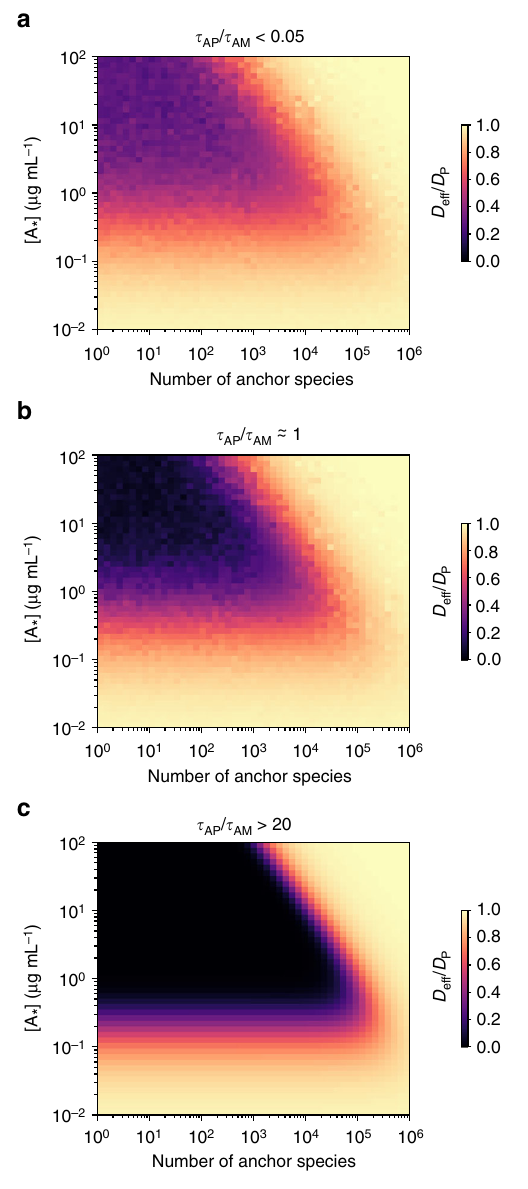
Fig. 5 Potential saturation of trapping potency of molecular anchors. Potential saturation of trapping potency was measured by effective diffusivity of nanoparticulates, in the context of molecular anchors in matrix containing other anchor species: a τ AP / τ AM = 0.05; b τ AP / τ AM = 1; and c τ AP / τ AM = 20. Parameter values used were D A / D P = 20, N = 20, and M ½ (cid:3) ¼ 10 5 μ m (cid:1) 3 (which corresponds to a 2% w/v gel with 10